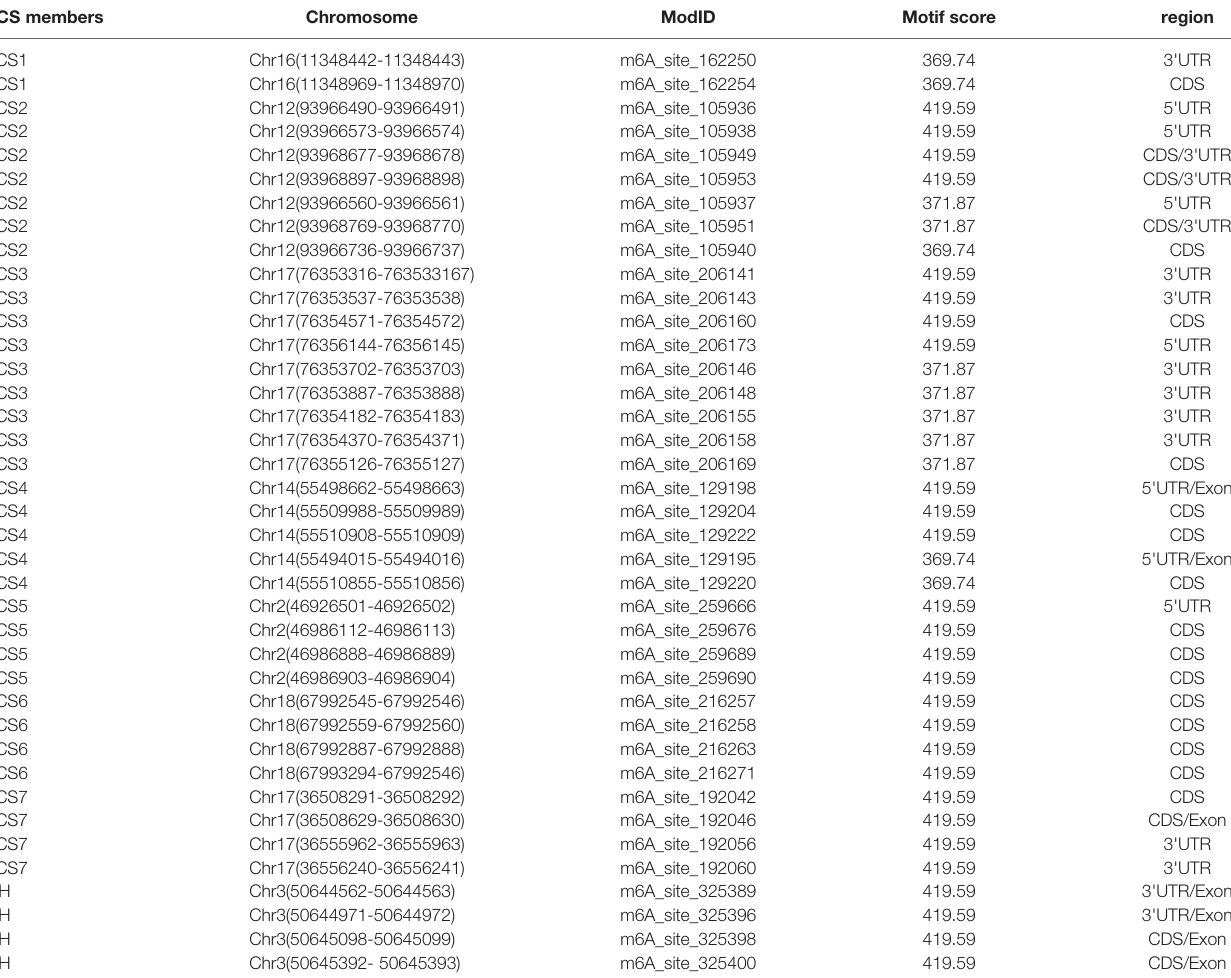
TABLE 3 | m6A modi fi cation loci in the mRNA of SOCS family members (main part). SOCS members Chromosome